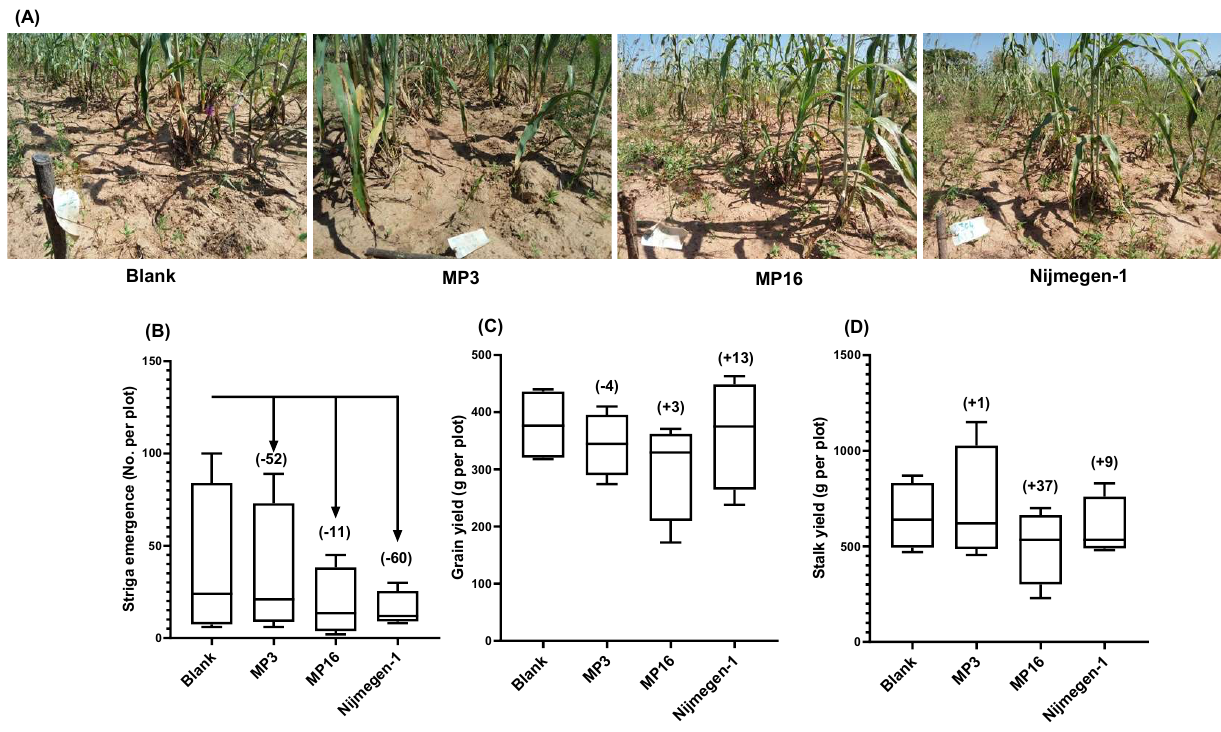
Figure 5. Striga emergence in response to different SL analogs for a naturally infested sorghum field in Burkina Faso. ( A ) Representative sorghum plots of farmer field, showing Striga emergence under different treatments. ( B ) Number of Striga plants that emerged in sorghum field under mock, MP3, MP16, or Nijmegen-1 treatment. ( C ) Sorghum grain yield per plot. ( D ) Sorghum stalk yield per plot. Data are means ± SE ( n = 4). Values in parenthesis are showing the percentage increase (+) or decrease (−) over mock treatment.